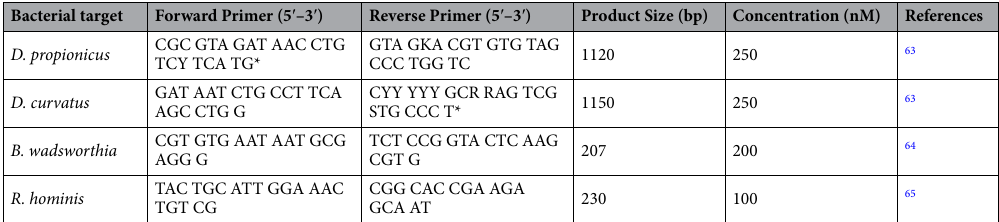
Table 1. 16S rRNA targeted PCR primer sequences used in this study and their expected amplicon sizes. *Denotes the use of a degenerate base pair. Y = C/T, R = A/G, S = C/G, W = A/T, K =